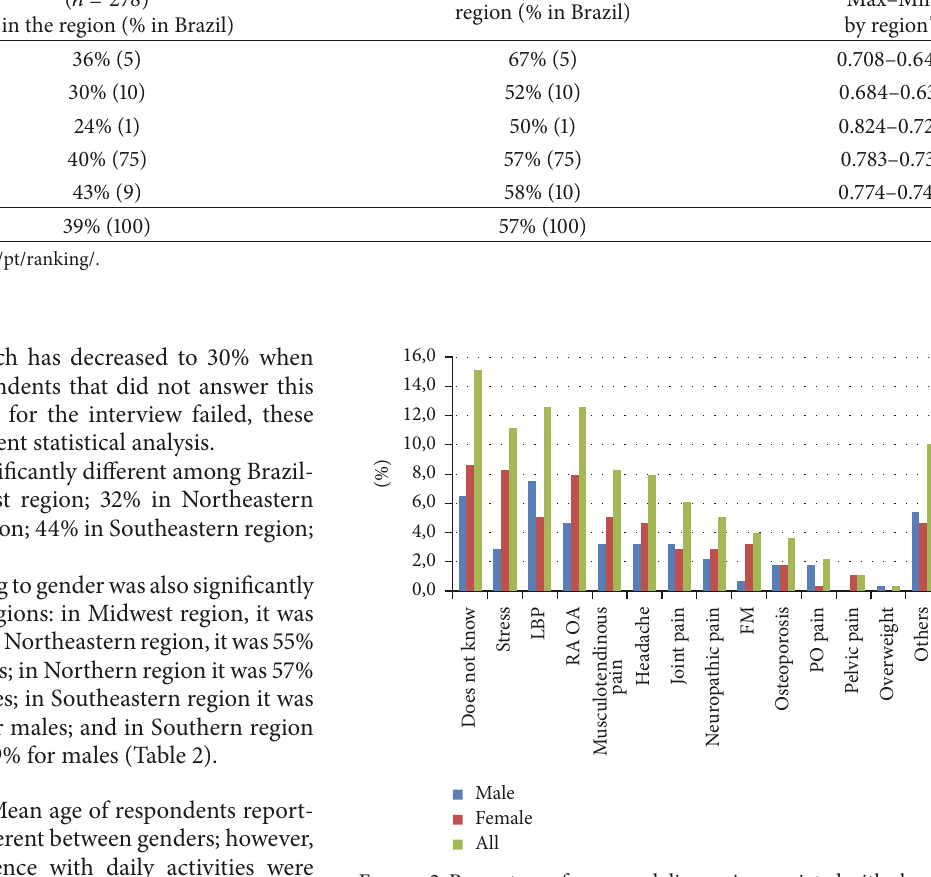
Figure 2: Percentage of cause and diagnosis associated with chronic pain with regard to gender. In Brazil in 2015-2016. LBP: low back pain, RA OA: rheumatoid arthritis or osteoarthritis, FM: fibromyalgia, and PO pain: postoperative pain.